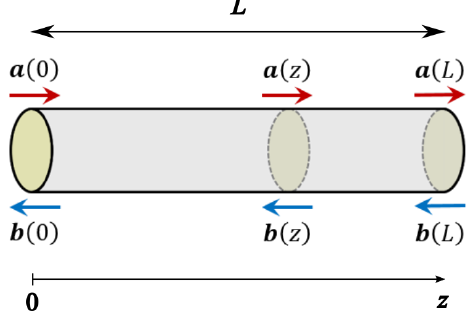
Figure 1. Schematics of the field